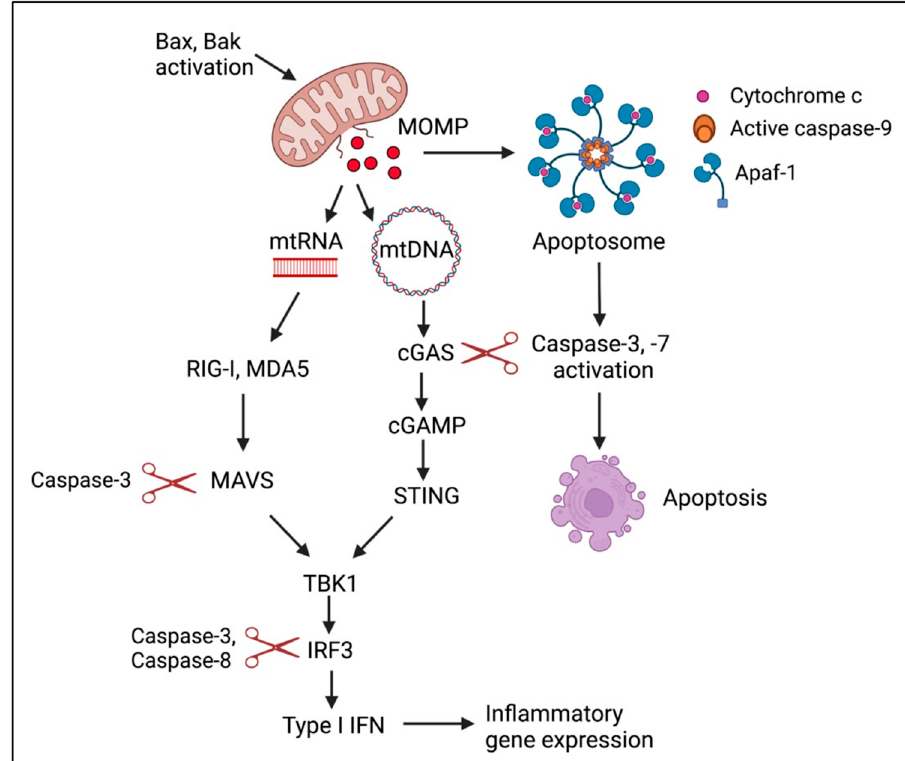
Figure 5. Apoptotic caspases block IFN production through cleavage of pathway components. Mitochondrial outer membrane permeabilization (MOMP) leads to the release of mtDNA as well as mtRNA that can be sensed by the cGAS/STING and MDA5/MAVS pathways, respectively, leading to Type I IFN production. Caspase activation resulting from MOMP blocks the IFN response by cleavage of various components of the cGAS/STING and RLR-MAVS signaling pathway. Activation of apoptotic caspase also suppresses IFN expression due to RNA and DNA virus infection (not shown). Created with BioRender.com (accessed on 18 July